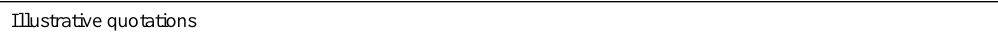
Table 5. Tailored experience. Illustrative